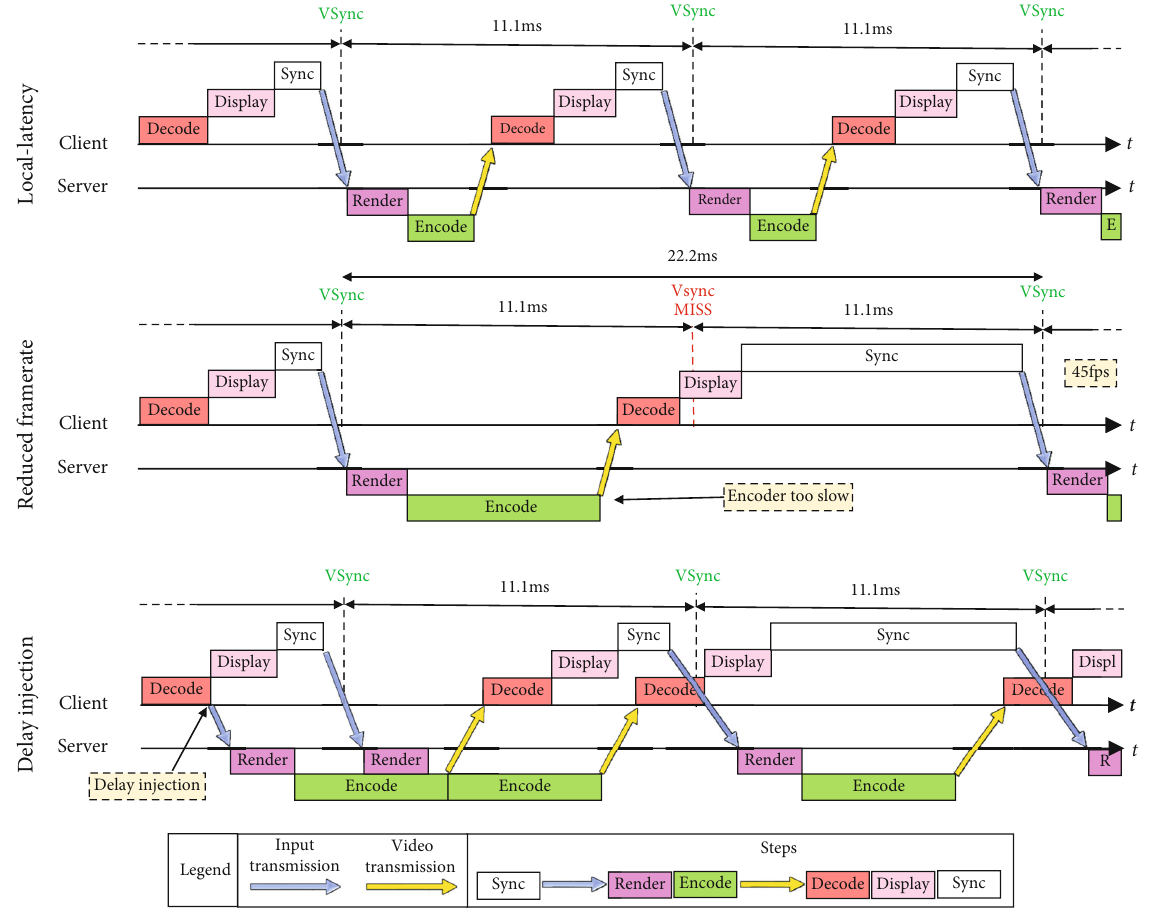
Figure 1: The three states of the synchronous system. (1) Local latency: all steps are complete within the refresh interval; latency is the same as local rendering. (2) Reduced framerate: the system cannot fi nish within the deadline, and fps will thus be reduced to half. (3) Delay injection: one frame delay is injected into the system. It is initialized by sending an extra input packet after decoding which will trigger parallel processing of two frames from then on, both delayed by one frame. The white Sync-bar is implementation-dependent and in this case refers mainly to the time consumption of the function WaitGetPoses() in the OpenVR API [75], which will return “ running start ” milliseconds before the next VSync deadline, typically 2ms